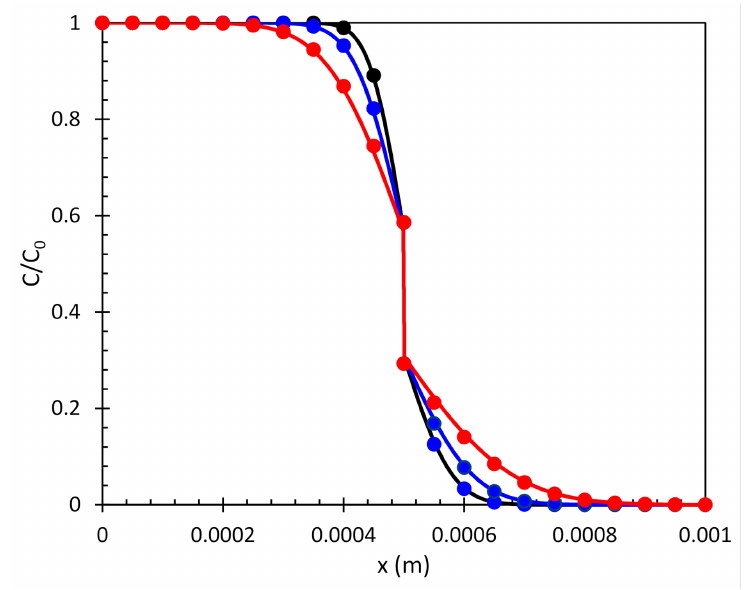
Figure A3. Concentration distribution in a 1D capillary. The line and dotes are the numerical simula- tion and analytical model. Black, blue, and red are 10 − 9 s, 2 × 10 − 9 s, and 5 × 10 − 9 s,